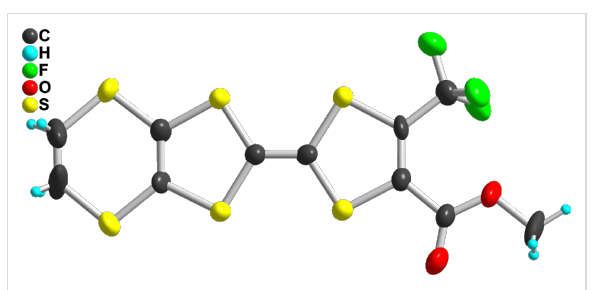
Figure 4: View of the 2bc molecule. Thermal ellipsoids are shown at the 50% probability